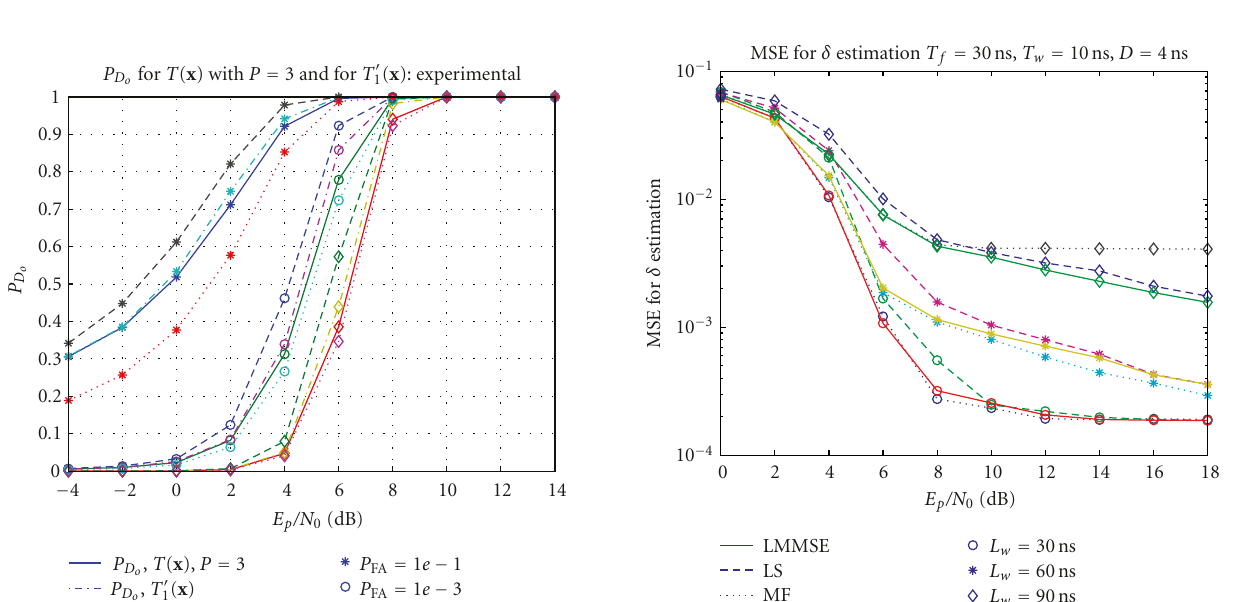
Figure 7: Experimental and theoretical P D ,1 performance compari- son for T ( x ) with P = 3 and T (cid:13) 1 ( x ) .